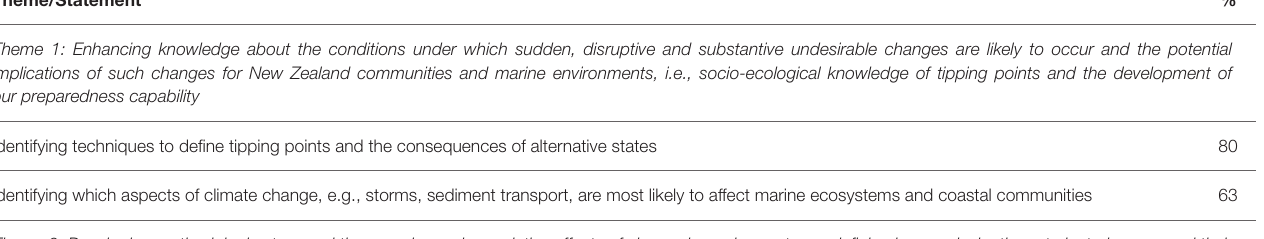
TABLE 2 | Statements ranked according to their combined percentage of ranks of either 1 and 2 from the survey emailed to workshop participants, organized by over-arching workshop themes.